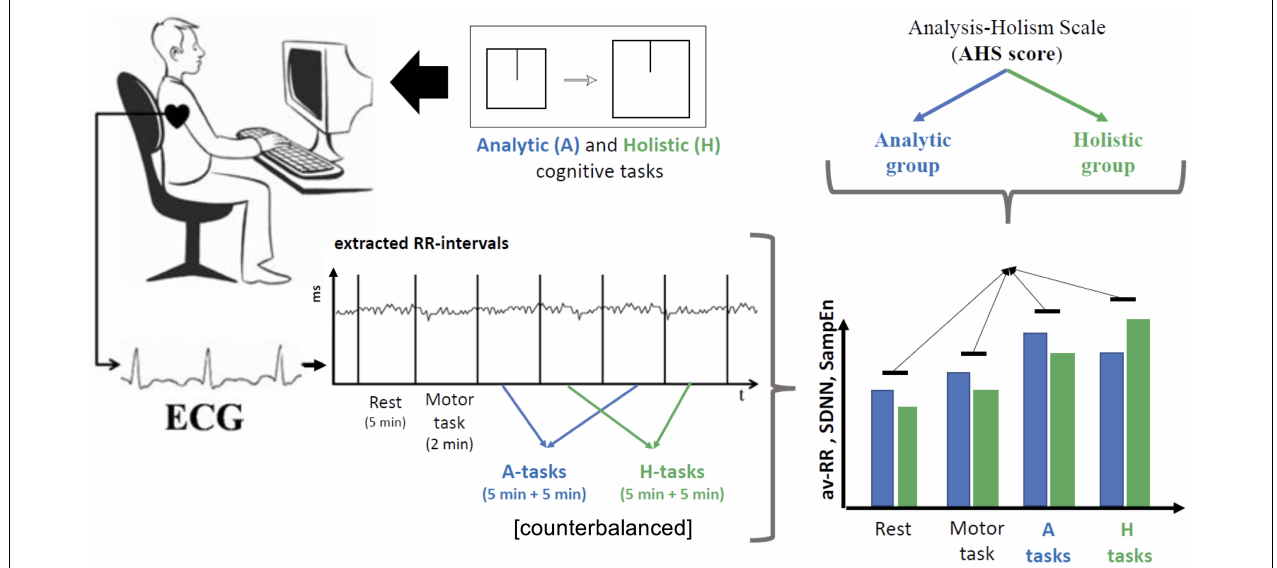
FIGURE 1 | Experimental design and procedure. Prior to the experiment, participants ( N = 52) filled an Analysis-Holism Scale (AHS) questionnaire and were divided into two groups: those with scores higher than median for the sample comprised the holistic group and the rest comprised the analytic group. ECG was recorded at rest (5 min, while sitting down with closed eyes without moving), during a simple motor task (2 min), and in the process of solving four blocks of cognitive tasks (5 min per each block). Cognitive tasks included presentation of two square frames (fields) containing lines (objects), sizes of which varied; participants were asked to compare objects either in relation to their fields (H-tasks) or irrespective of the fields (A-tasks). Response times, success rates and the dynamics of HRV indexes (av-RR, SDNN and SampEn) were compared between the two groups of participants.